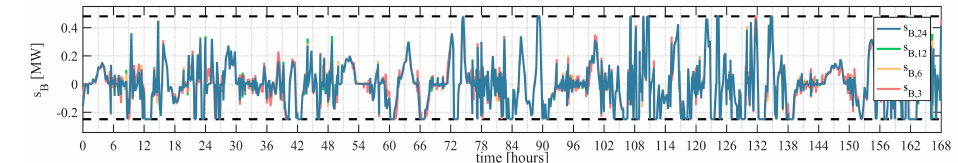
Figure 13. The B power profiles achieved by OPEM over a generic week by employing different time horizons.